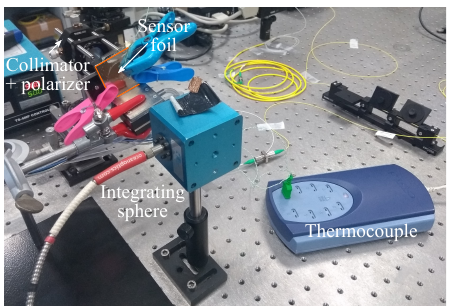
Figure 30. The measured and simulated resonant wavelength shift ∆ λ as a function of the refractive index (RI) of the surrounding medium n c for an OrmoCore GMR grating sensor foil.